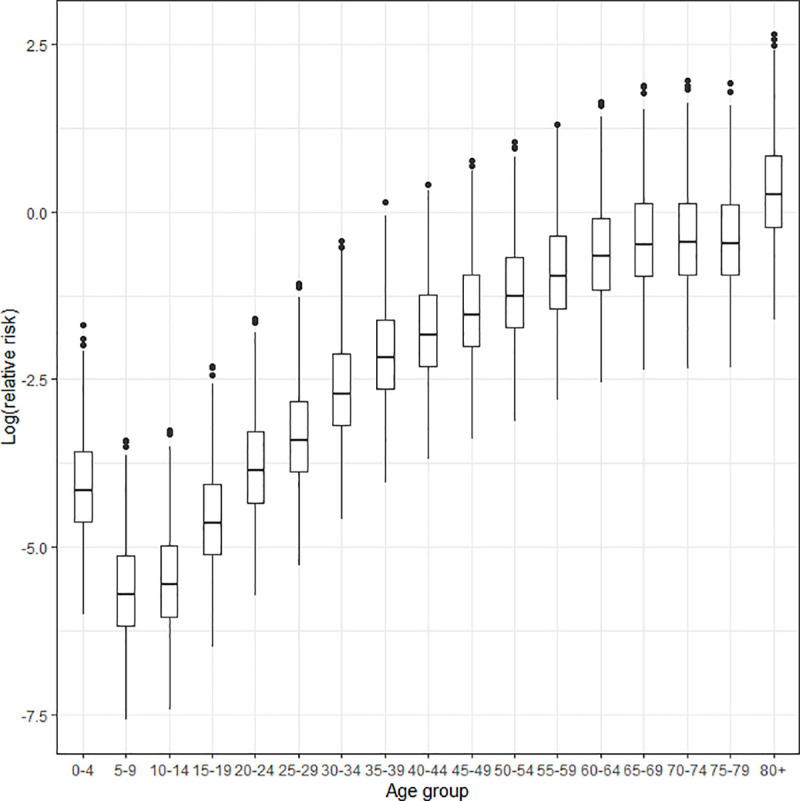
Log relative mortality risk according to conventional five-year age groups for both sexes in Brazil, 2020.Source: Brazilian Ministry of Health 2020.